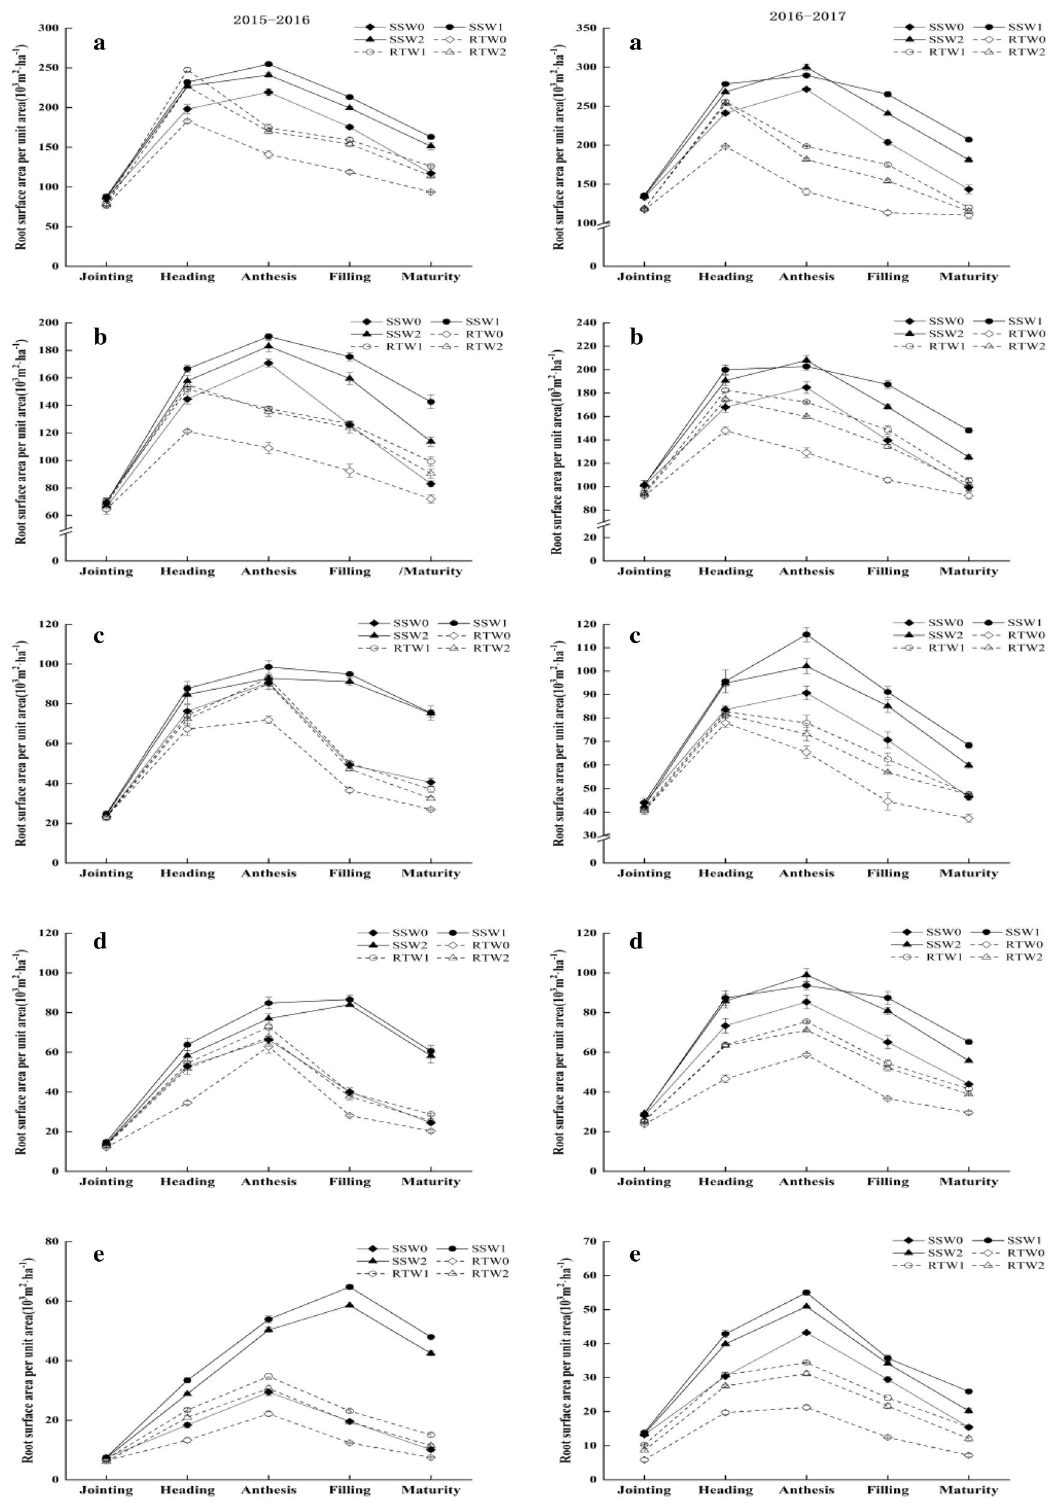
Figure 3. Effects of tillage practice and irrigation regime on the root surface area per unit area of winter wheat in different soil